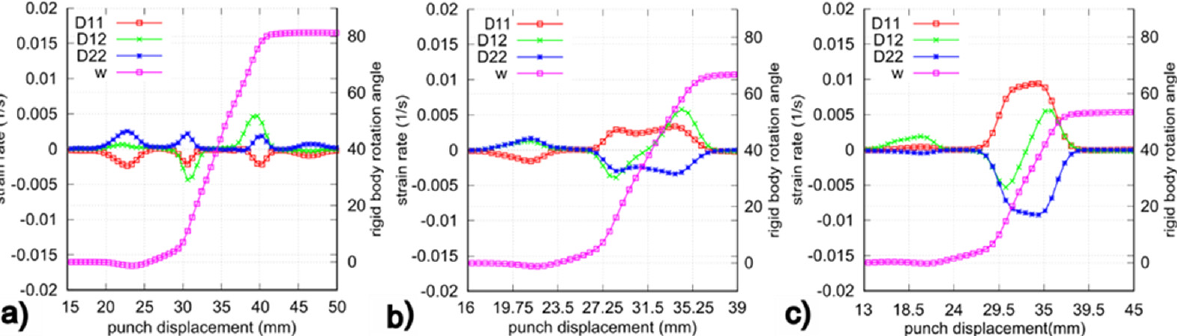
Figure 10. Evolution of components of symmetric part of the velocity gradient tensor and accumu- lative rigid body rotation angle as a function of punch displacement: ( a ) point 4; ( b ) point 11; and ( c ) point 18.